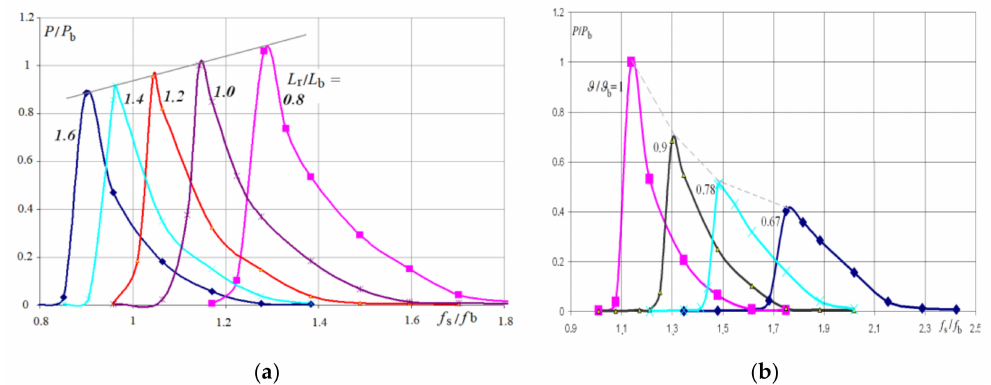
Figure 7. Relative discharge power as a function of frequency for: ( a ) various values of L r ; ( b ) various values of ϑ , reproduced from Przegl ˛ad Elektrotechniczny [34]; base values: L b = 1 mH, ϑ b = 9.17, f b = 1 / (2 π ( C 1 L b ) 1 / 2